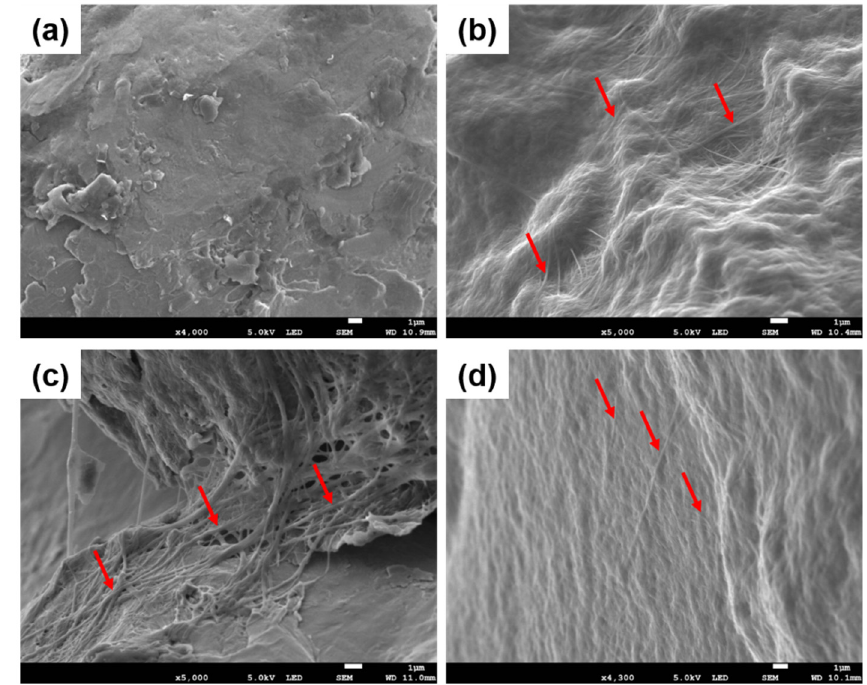
Figure 2. SEM images of ( a ) uncoated Ti, and ( b ) Ti_Col, ( c ) Ti_Col_low and ( d ) Ti_Col_high coatings. Ti: titanium alloy Ti6Al4V; Ti_Col: collagen-coated Ti; Ti_Col_low: collagen and low PG concentration-coated Ti; Ti_Col_high: collagen and high PG concentration-coated Ti. Red arrows indicate collagen fibrils.